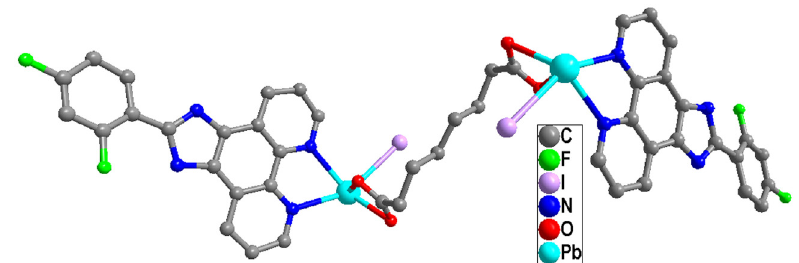
Figure 2: View of the dinuclear structure of 1